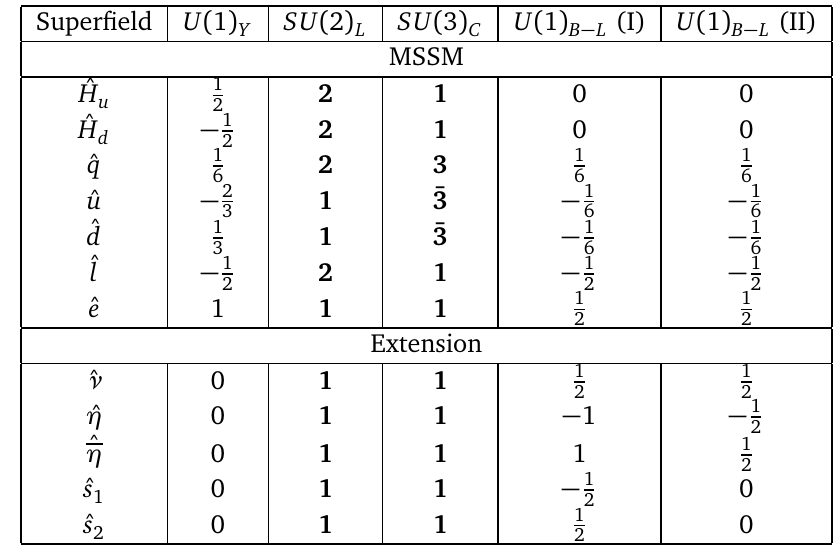
Table 4: Chiral Superfields of